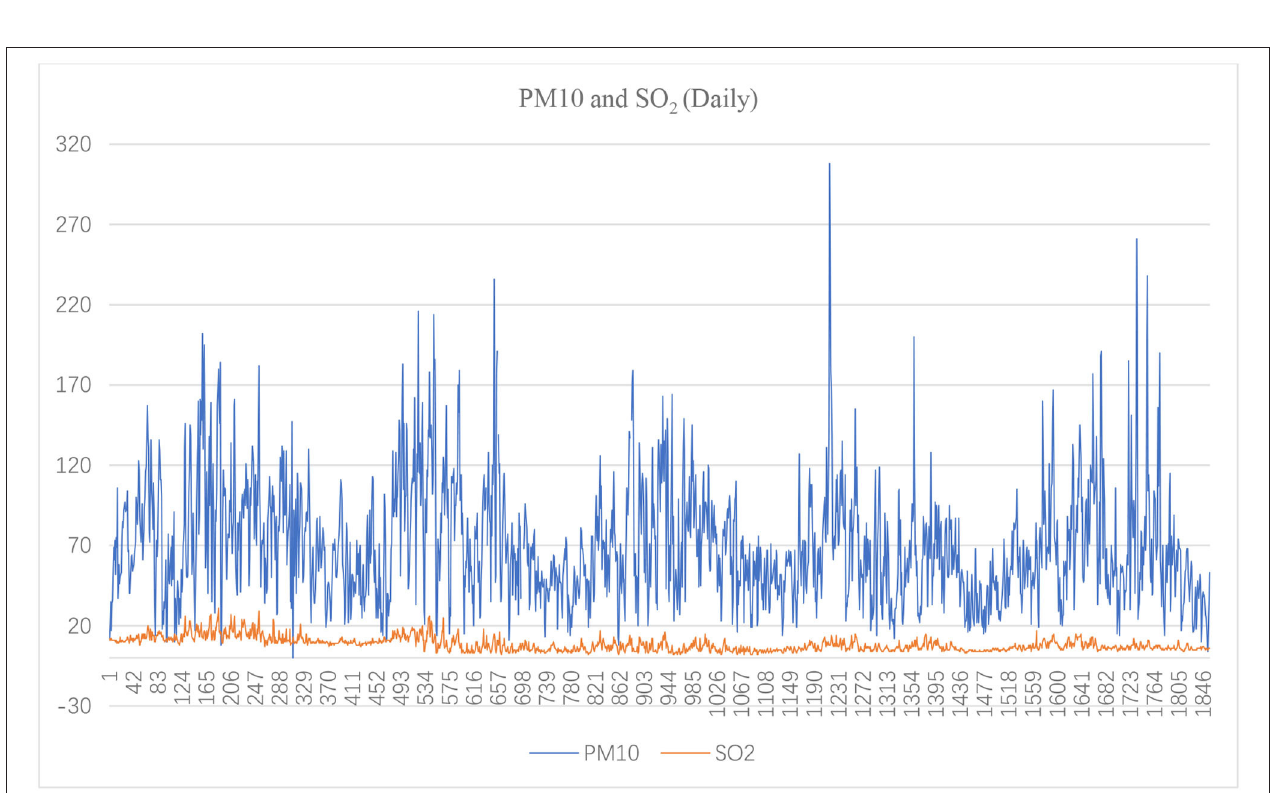
FIGURE 3 | Daily PM10 and SO 2 of Hefei from July 2016 to July 2021( µ g/m 3 ).